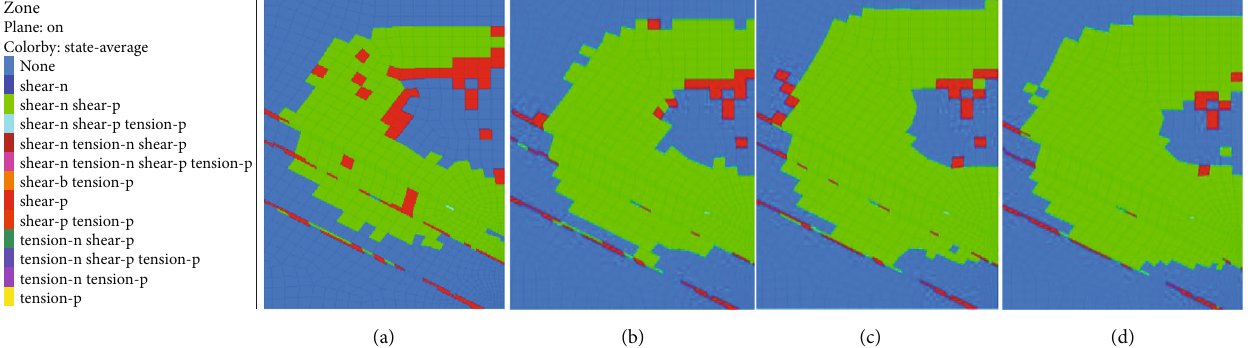
Figure 22: The change of plastic zone of roadway fl oor in 302 mining area when the cutting position is 380m ahead of schedule. (a) Working face advancing 40m; (b) working face advancing 80 m; (c) working face advancing 120m; (d) working face advancing 160